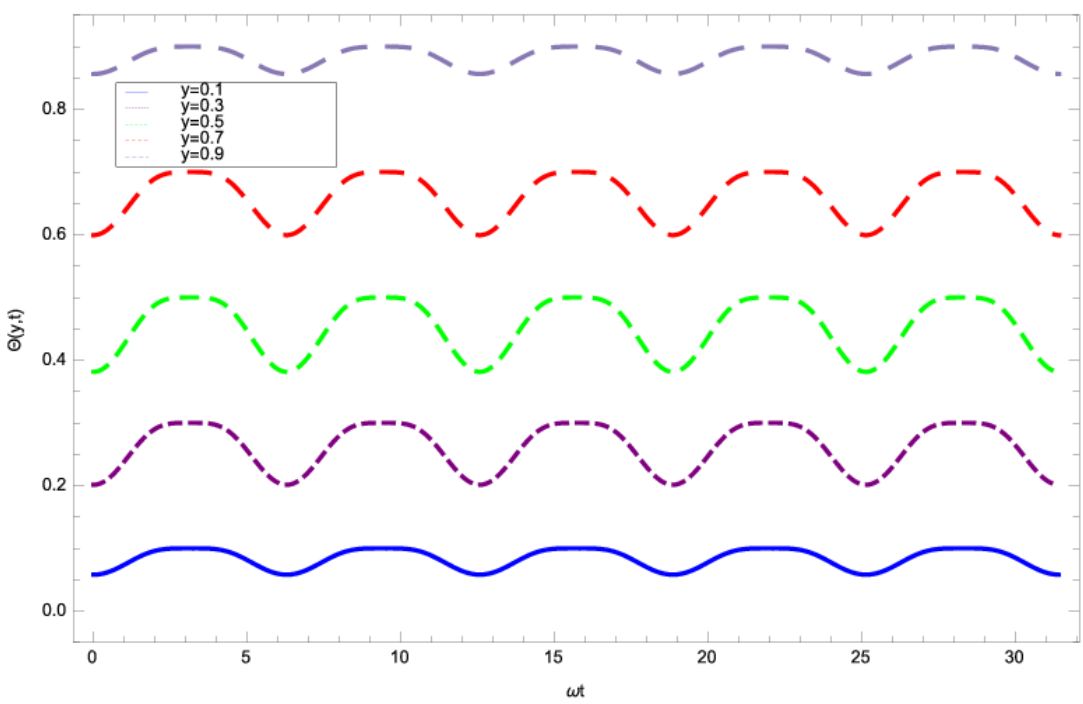
Figure 5. The 2D presentation of temperature distribution at time level ω t ∈ ( − 4 π ,4 π ) , when ω = 0.2, m = 0.10, M = 0.2, W e = 0.1, Ec = 9. Appl. Sci. 2017 , 7 , 369